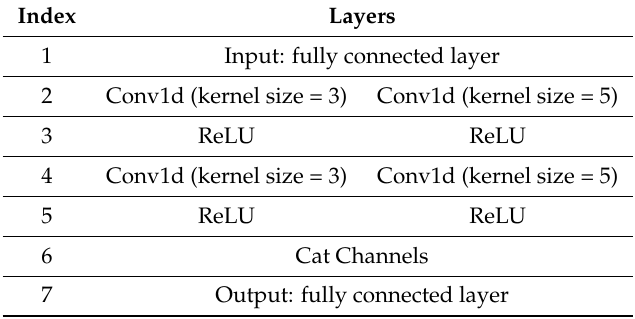
Table A1. The Structure of Enhanced Multi-scale Combined Convolutional Neural Network.